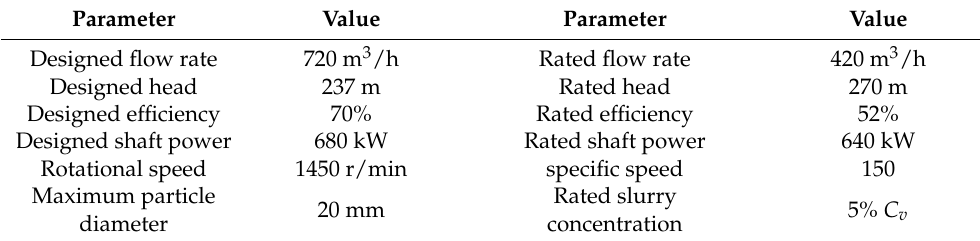
Table 3. Design parameters of China’s “13th Five-Year Plan” lifting pump.